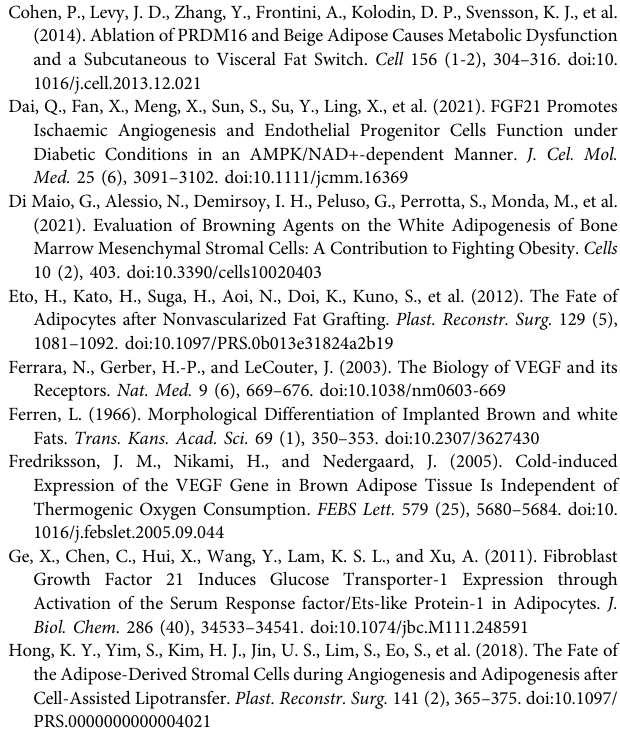
Supplementary Figure S1 | CL316243 and SR59230A had little effect on body weight and energy expenditure. (A and B) Both CL316243 and SR59230A did not alter the body weight and food intake of the mice. (C,D and E) Indirect calorimetry data showing the oxygen consumption, CO 2 production and heat production